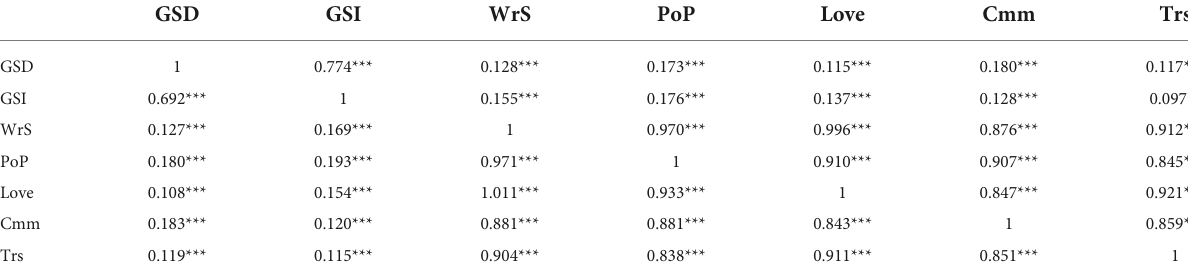
TABLE 3 Latent correlations in the positive model.